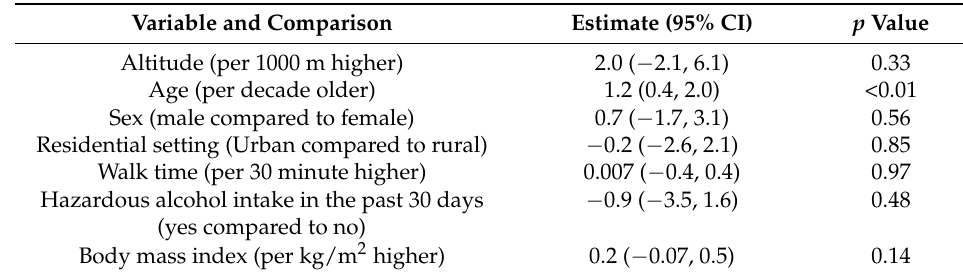
Table A3. Estimates of the mean glycated hemoglobin (HbA1c) for altitude in a multivariate ANCOVA and associations for confounding